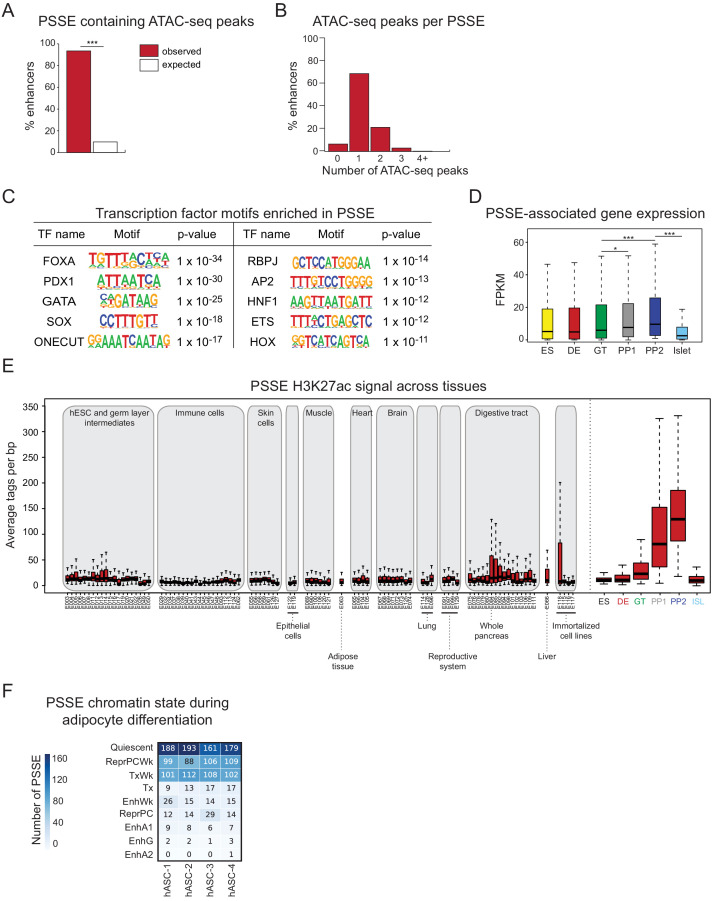
Characterization of pancreatic progenitor-specific stretch enhancers.(A) Percentage of PSSE overlapping with at least one ATAC-seq peak at PP2. Enrichment analysis comparing observed and expected overlap based on random genomic regions of the same size and located on the same chromosome averaged over 10,000 iterations (***p<1 × 10−4; permutation test). (B) Percentage of PSSE overlapping 0, 1, 2, 3, or 4+ ATAC-seq peaks at PP2. (C) Enriched transcription factor (TF) binding motifs with associated p-values at ATAC-seq peaks at PP2 intersecting PSSE. Fisher’s exact test, two sided, corrected for multiple comparisons. (D) Box plots showing mRNA levels based on RNA-seq of nearest expressed genes (fragments per kilobase per million fragments mapped (FPKM) ≥1 at PP2) for PSSE at each developmental stage and in islets (*p=1.10 × 10−2 for GT vs PP1; ***p=1.80 × 10−8 for GT vs PP2, p<2.2 × 10−16 for PP2 vs islet; Wilcoxon rank sum test, two sided). Plots are centered on median, with box encompassing 25-75th percentile and whiskers extending up to 1.5 interquartile range. n = 3 replicates from independent differentiations at ES, DE, GT, PP1, and PP2, respectively; n = 3 islet replicates. (E) Box plots showing H3K27ac signal at PSSE in tissues and cell lines from the ENCODE and Epigenome Roadmap projects as well as in developmental intermediates and islets (ISL). Plots are centered on median, with box encompassing 25-75th percentile and whiskers extending up to 1.5 interquartile range. See also Figure 2—source data 4. (F) Number of PSSE overlapping defined chromatin states in human adipose stromal cells from preadipose (hASC1) to mature adipose state (hASC4) (from Varshney et al., 2017). ChromHMM classifications: Quiescent; ReprPCWk, Weak Repressed PolyComb; TxWk, Weak Transcription; Tx, Strong Transcription; EnhWk, Weak Enhancer; ReprPC, Repressed Polycomb; EnhA1, Active Enhancer 1; EnhG, Genic Enhancer; EnhA2, Active Enhancer 2.